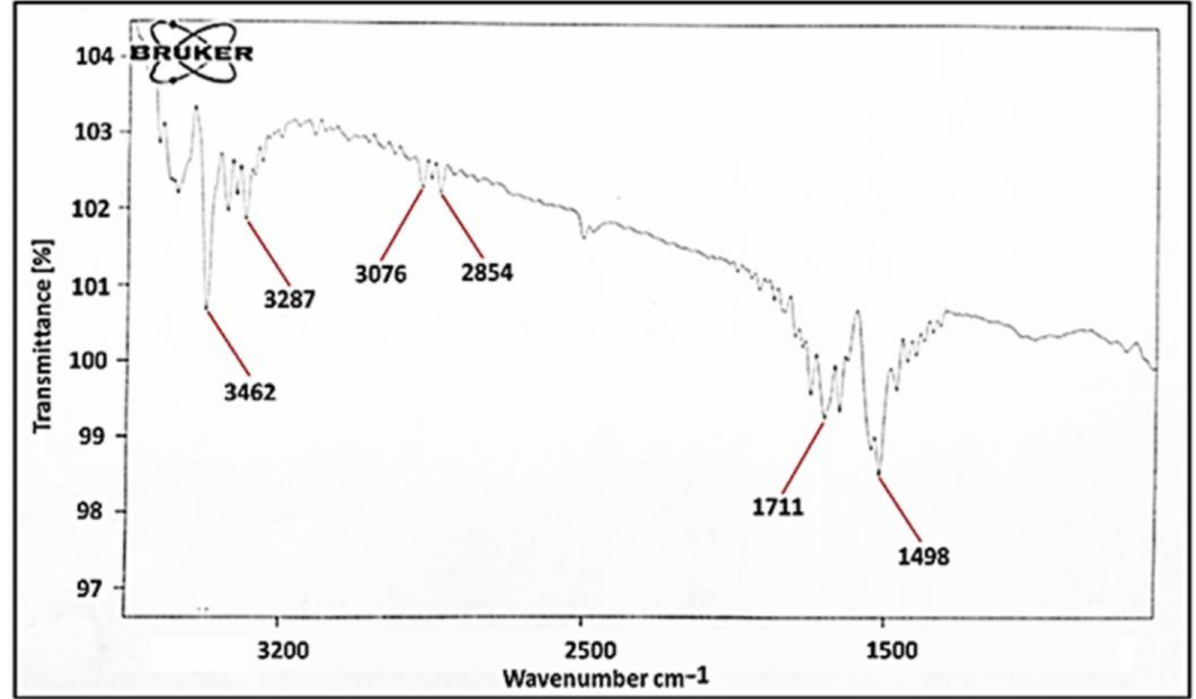
Figure 4. FTIR spectra of